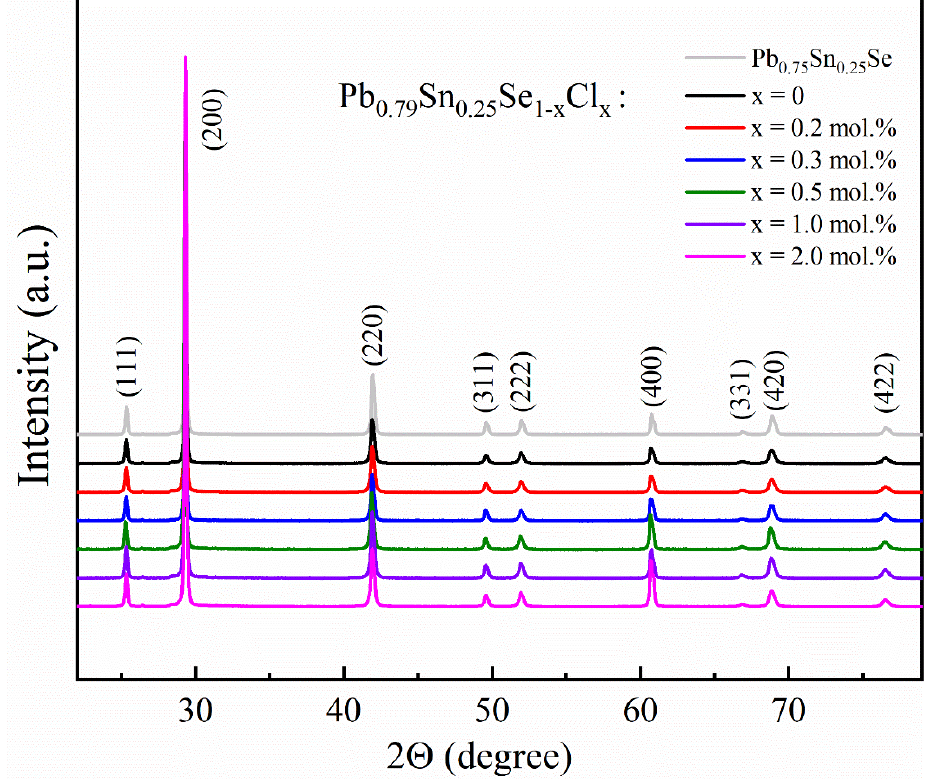
Figure 1. Powder X-ray diffraction (XRD) peaks of the Pb 0.79 Sn 0.25 Se 1 − x Cl x (x = 0.0, 0.2, 0.3, 0.5, 1.0, 2.0 mol.%) and Pb 0.75 Sn 0.25 Se compounds.